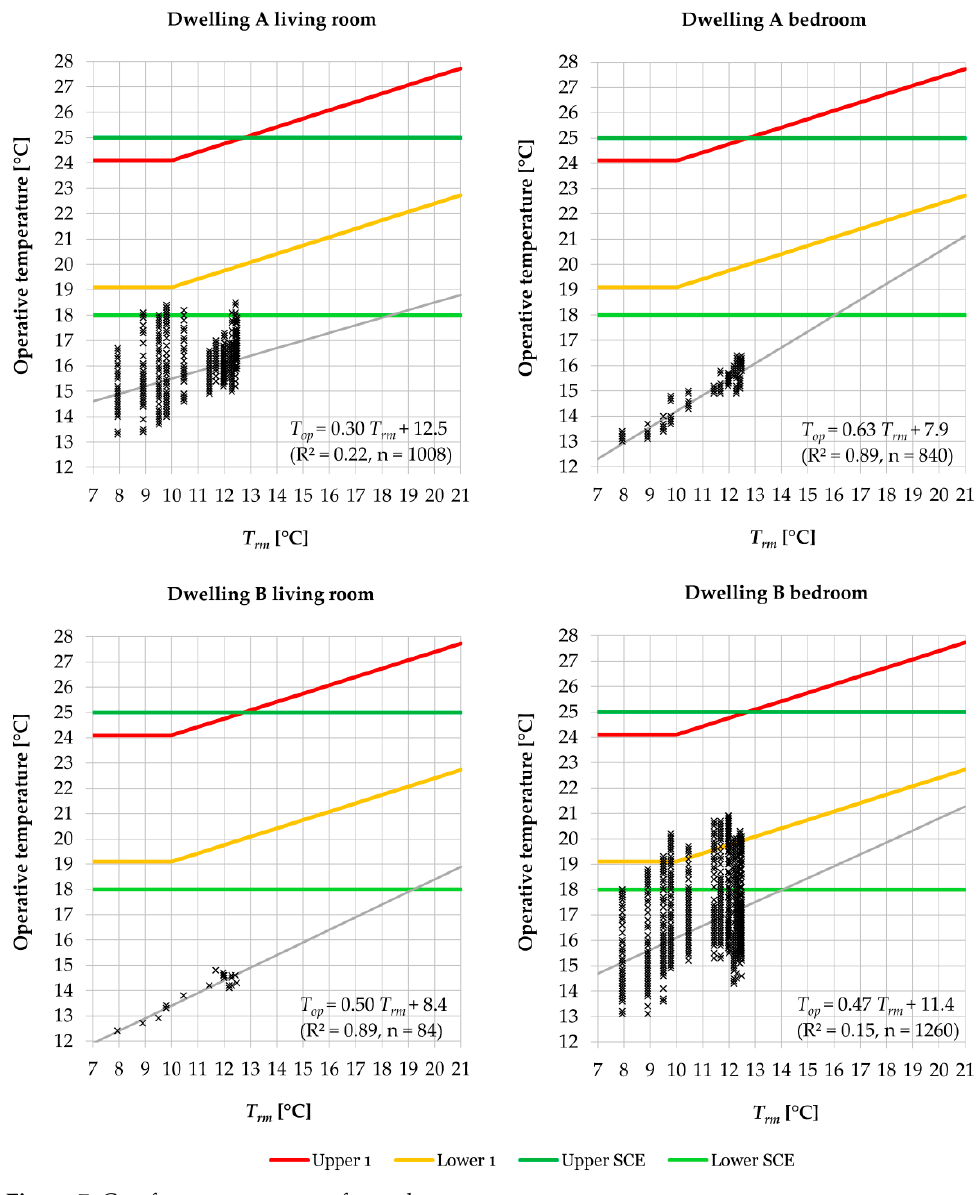
Figure 7. Comfort assessment performed.